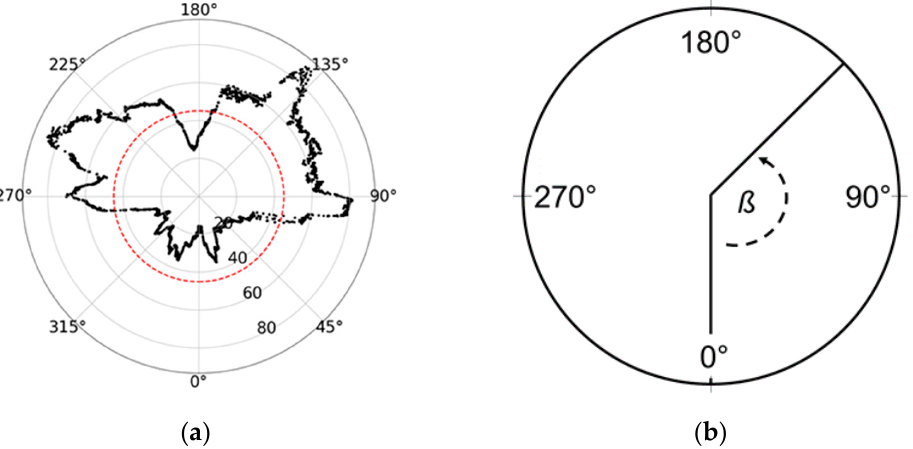
Figure 6 . ( a ) Polar plot of Pa ( β ) with radial scale unit in µm; ( b ) sketch of the local orientation within a channel β .